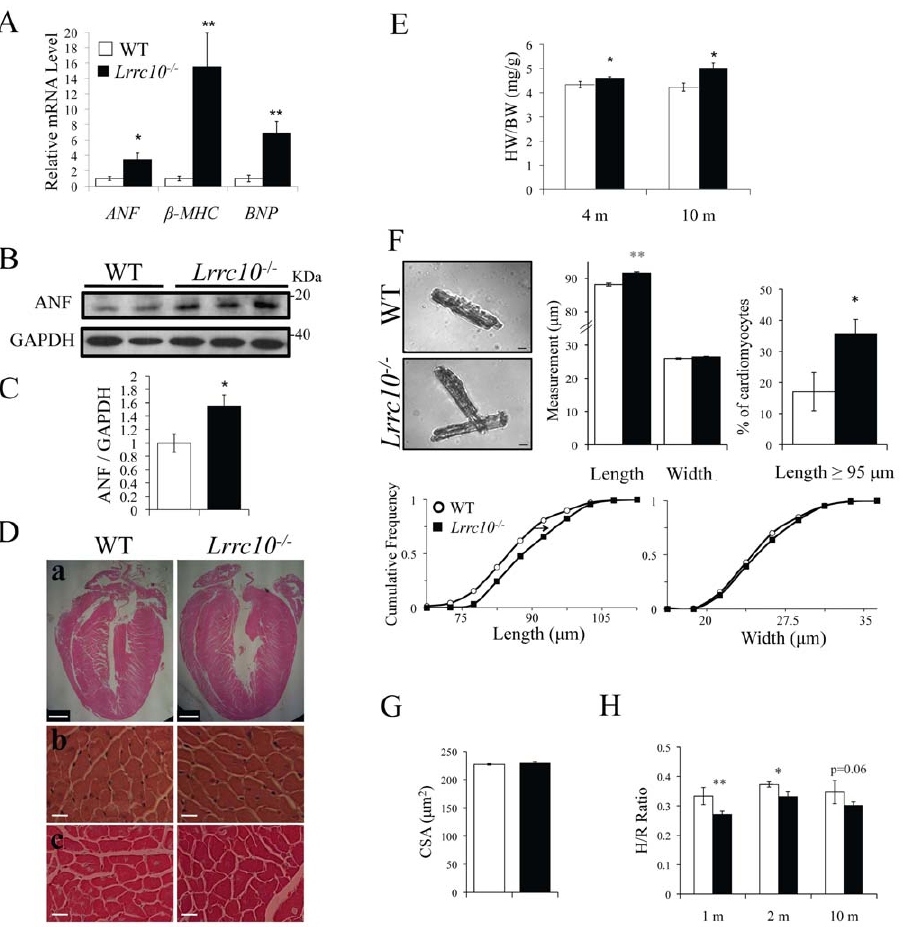
Figure 2. Characterization of Lrrc10 2 / 2 hearts. (A) qRT-PCR analysis for ANF ( Nppa ), b -MHC ( Myh7 ), and BNP ( Nppb ) demonstrates re-expression of the fetal genes in Lrrc10 2 / 2 hearts at 4 months of age (n=7–8). (B) Representative immunoblot and (C) quantitation of ANF expression in WT and Lrrc10 2 / 2 hearts (n=4). Expression level was normalized to GAPDH as a loading control. (D) Histology of WT and Lrrc10 2 / 2 mice at ten months of age. Representative (a) frontal midline heart sections (scale bar=1 mm) and (b) 40X high magnification images (scale bar=20 m m) of H&E and (c) Masson’s trichrome staining. (E) Wet heart weight to body weight ratios indicate increased size of Lrrc10 2 / 2 hearts in adulthood (n=6–12). (F) Isolated adult WT and Lrrc10 2 / 2 ventricular cardiomyocytes were micrographed ( top left, scale bar=10 m m) to measure cell length and width (n=384 cells from 3 WT hearts and 435 cells from 3 Lrrc10 2 / 2 hearts). (G) Cardiomyocyte cross-sectional area (CSA) in WT and Lrrc10 2 / 2 hearts at 10 months (n=4–6). (H) To measure relative left ventricle wall thickness as compared to left ventricle size, H/R ratio was calculated from echocardiography data. H/R ratio = (LVPWd + LVAWd)/LVIDd. m , months.